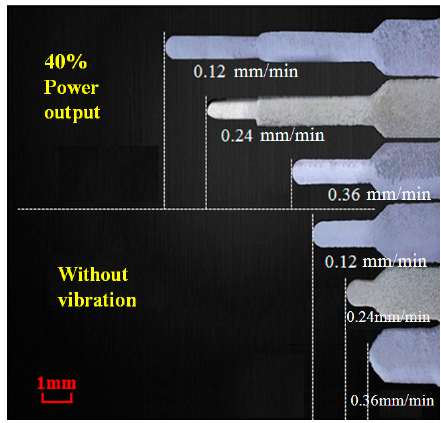
Figure 7. Ultrasonic extrusion length of Zr35 MG at various microextrusion rates. Table 3. Extrusion length of Zr35 at different microextrusion rates.